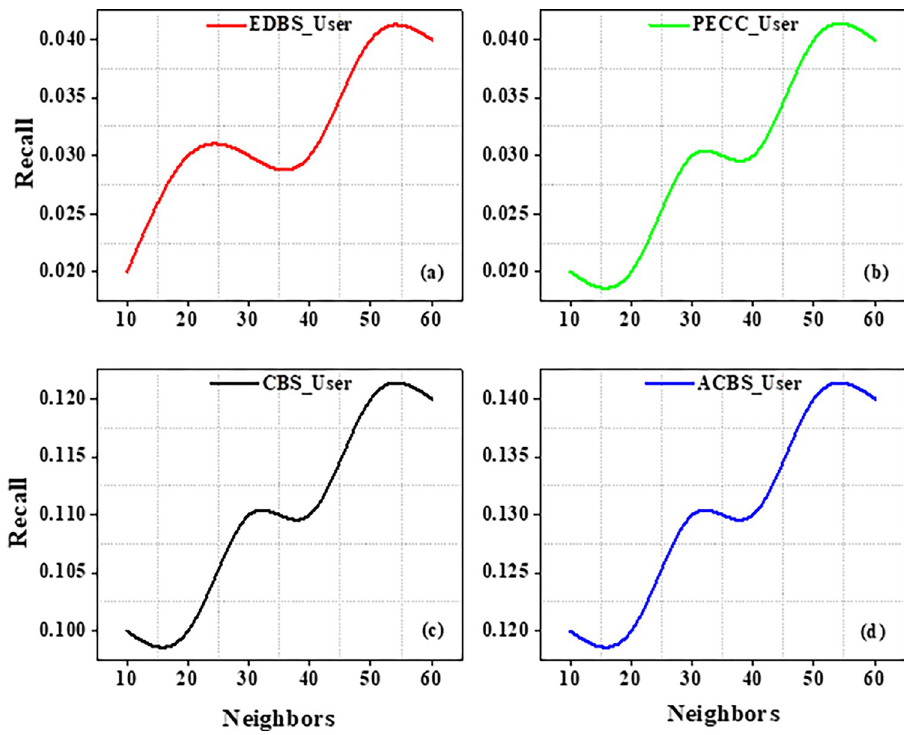
Fig 7. Recall with different neighbors.